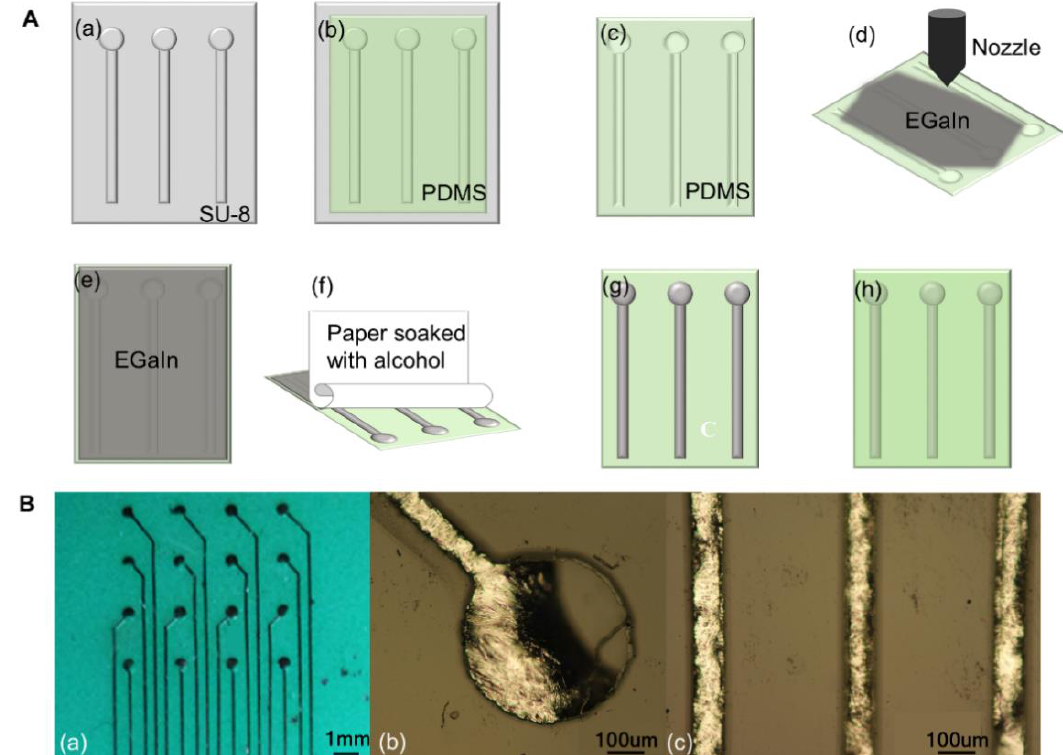
Figure 5. Technologies of spraying and wiping. ( A ) Fabrication process: ( a ) Photolithography model; ( b ) Pouring PDMS onto the photolithography model; ( c ) PDMS substrate with micro-channels; ( d , e ) Spraying liquid metal with an airbrush; ( f ) Removing needless liquid metal with the help of paper soaked with absolute ethyl alcohol; ( g ) The final circuit; ( h ) Encapsulating the circuit. ( B ) An electrode array fabricated by spraying and wiping: ( a ) The electrode array; ( b ) The micrograph of the electrode plate; ( c ) The micrograph of lines. Reproduced with permission from [105].